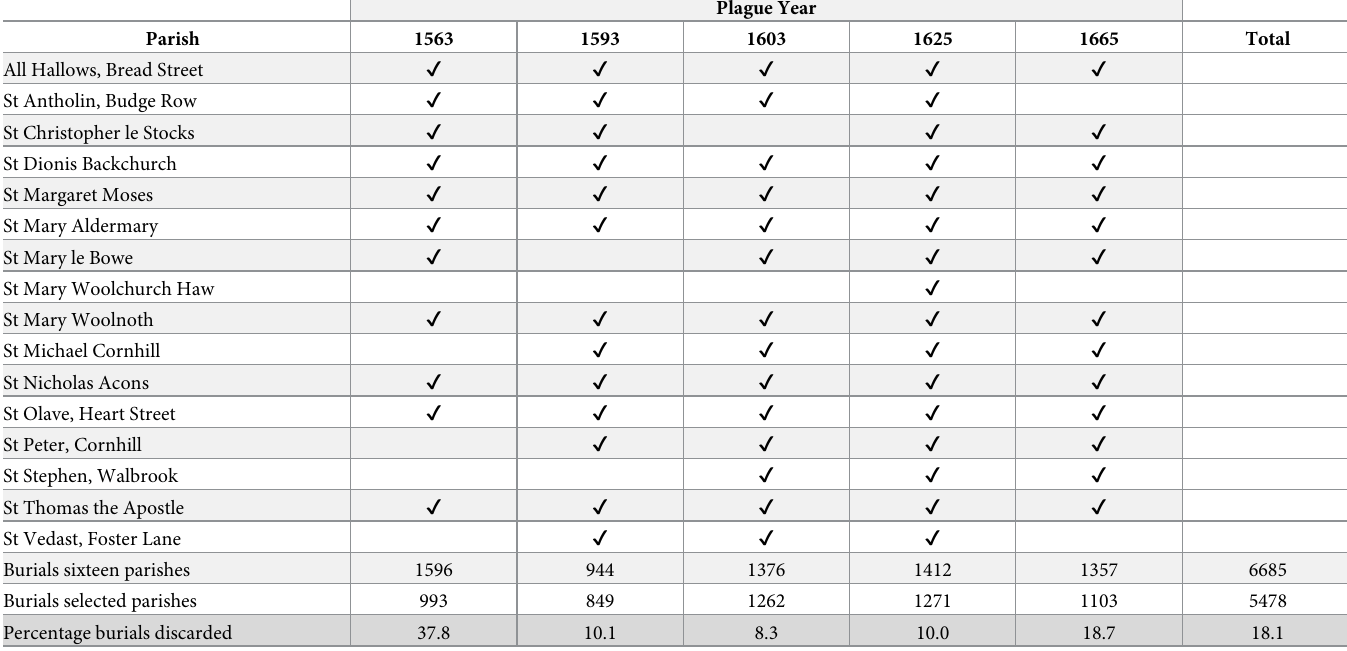
Table 1. Parishes selected for the detailed analysis of ‘adults’, ‘servants’ and ‘children’. The total number of burials for the sixteen parishes in each plague year and thus the percentage number of burials discarded for this analysis are also